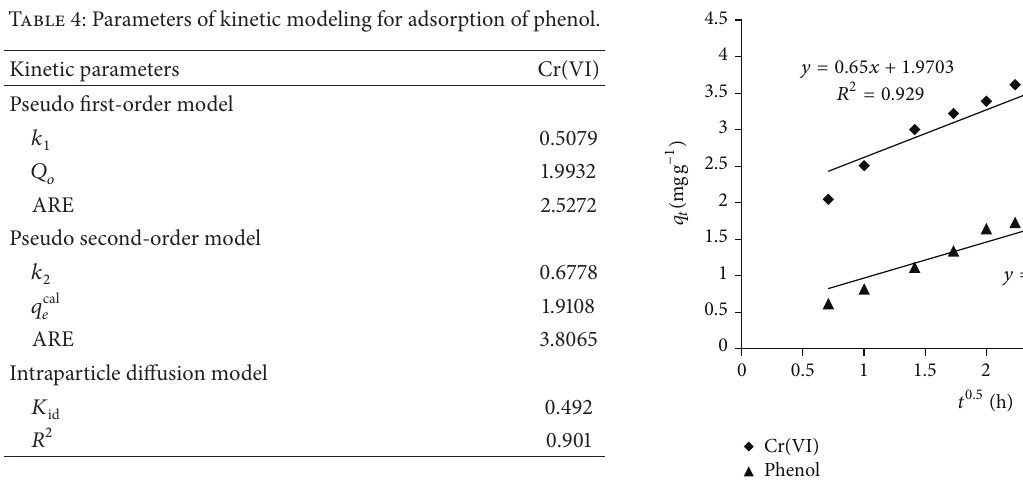
Figure 10: Intraparticle diffusion plot for simultaneous adsorption of Cr(VI) and